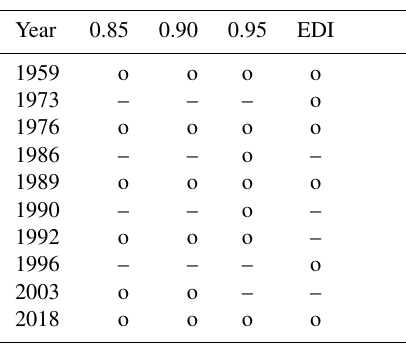
Table 5. As in Table 3 but for drought in the GEN region during the